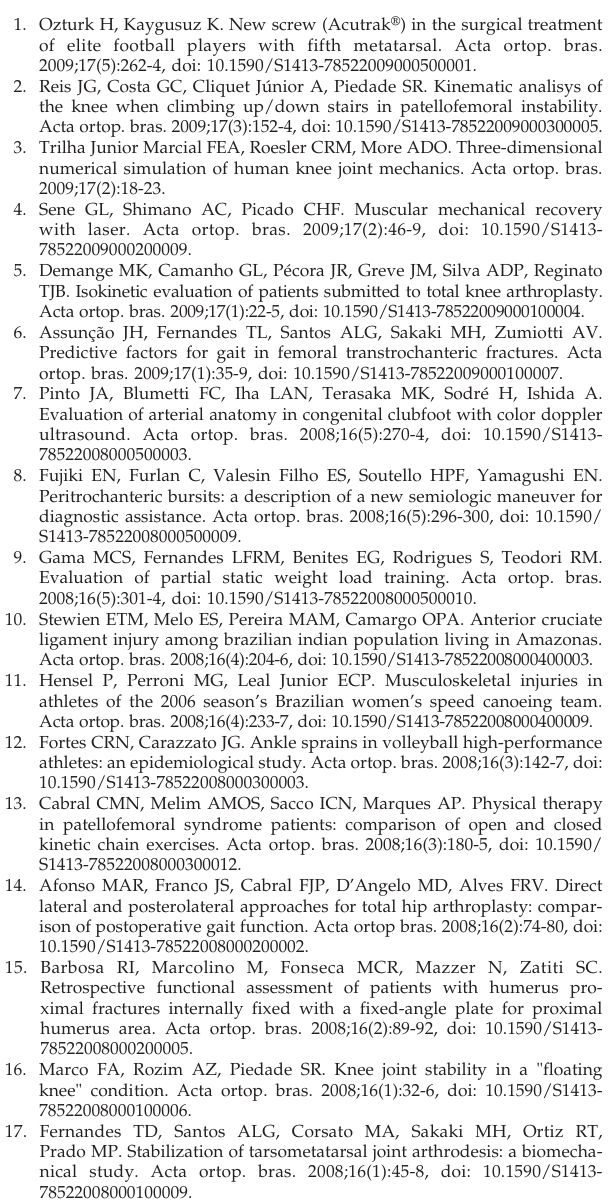
Table 2 - Subject index of Brazilian journal publications on the locomotor